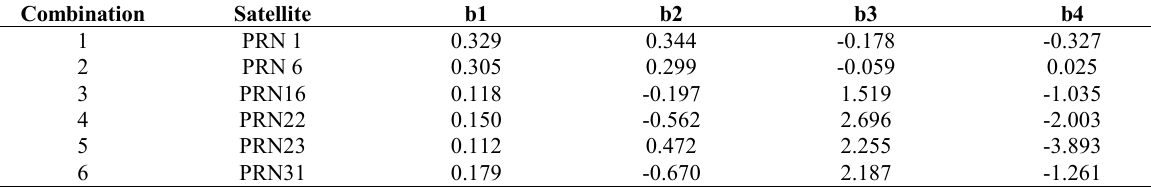
Tab. 1 Single star nonlinear regression model regression